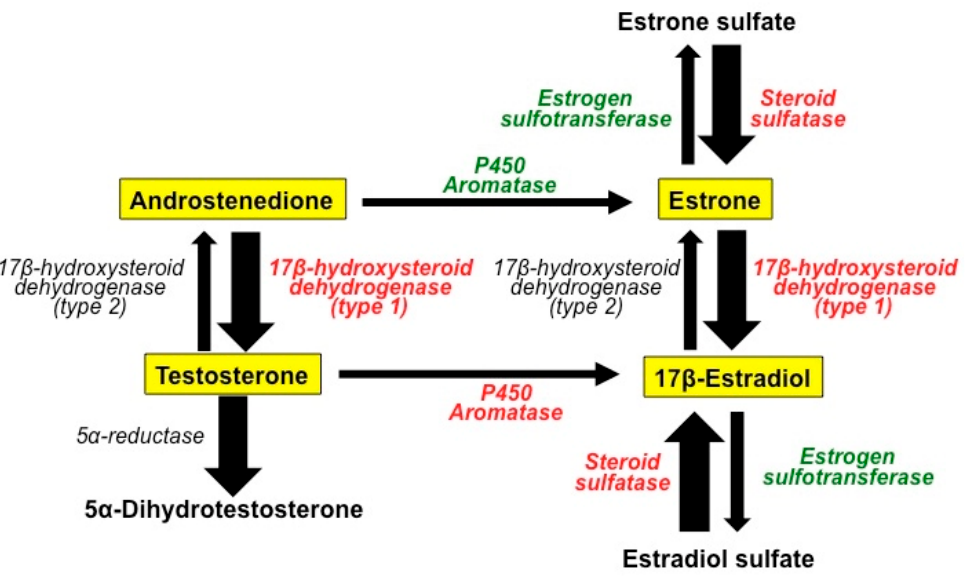
Figure 1. The basic enzymatic mechanisms involved in the transformation of steroids in the normal mammary gland and in breast cancer tissue. Melatonin acts as a selective estrogen enzyme modulators (SEEM) by inhibiting the expression and activity of the enzymes (labeled in red) responsible for the formation of biologically active estrogens from steroids with low biological activity, whereas it increases the expression and activity of the enzymes (labeled in green) involved in the transformation of estrogens into their inactive sulfoconjugates. In breast cancer tissue, the local production of steroids is biased towards production of the more active forms (wide